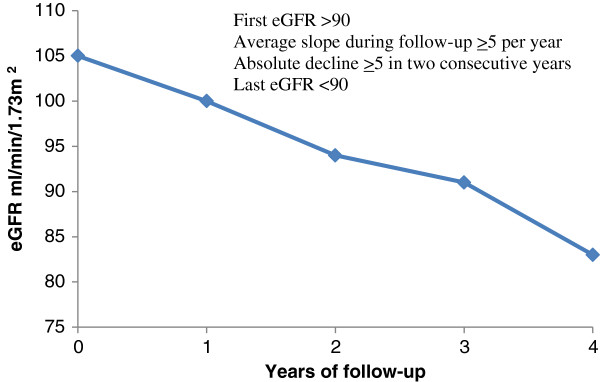
RP definition A.